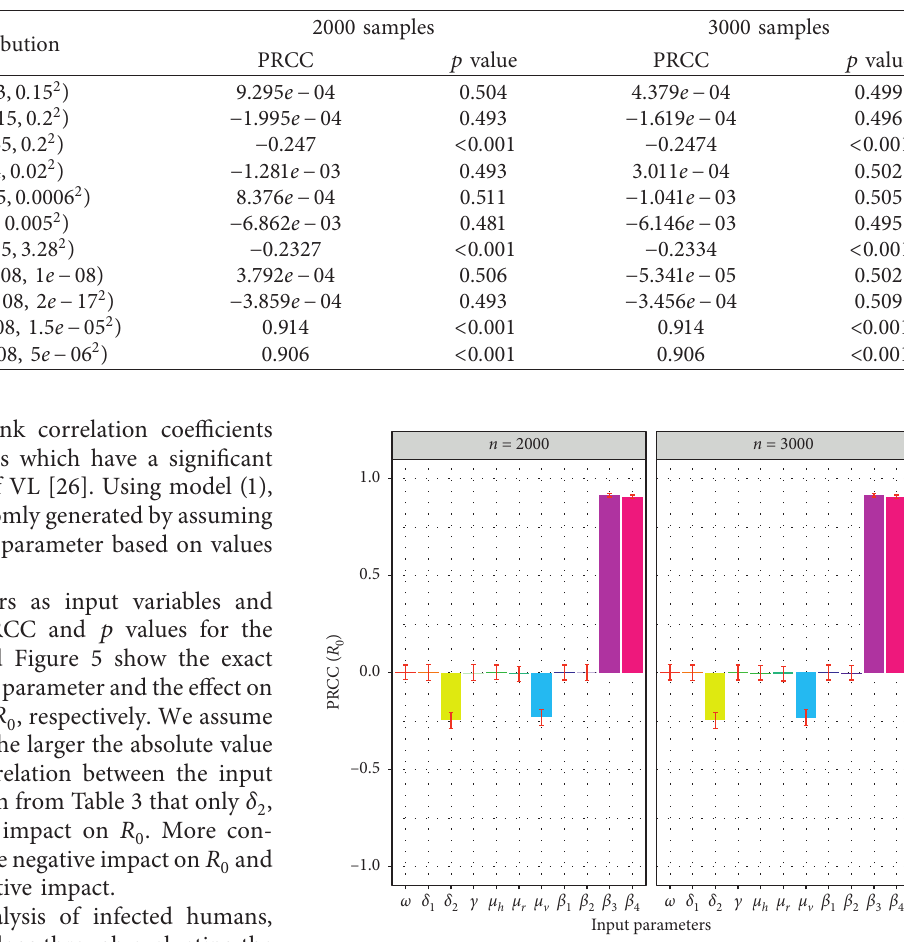
Figure 5: Partial rank correlation coefficient (PRCC) results for the on each dependence of R 0